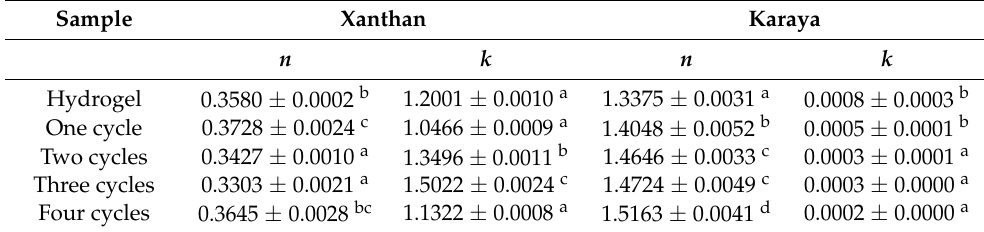
Table 3. Rheological parameters according to the power’s